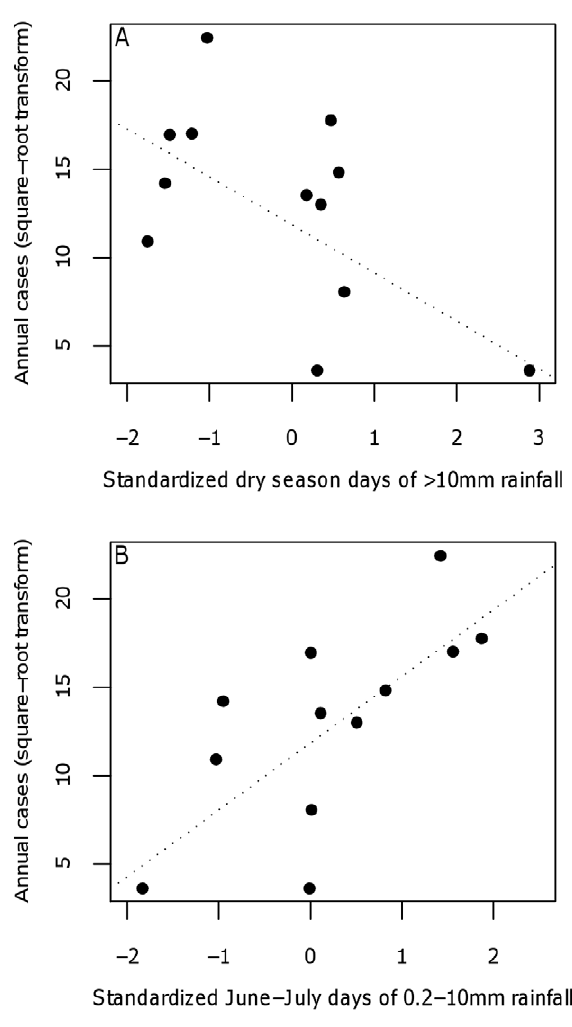
Figure 5. Association between rainfall and plague occurrence. Relationship between square-root transformed number of annual suspect plague cases and (A) the standardized number of days of . 10 mm in the dry season (December-February) prior to the start of the plague year in August (zero-year lag) and (B) the standardized number of days of 0.2–10 mm rainfall in June and July prior to the start of the plague year (zero-year lag). The rainfall data is the weighted ensemble of all seven rainfall datasets included in our analyses (TRMM, CMORPH, FEWS-NET, NCEP/DOE, ERA-Interim, GPCP, and Observation- al). Dotted lines are the regression coefficients estimates from the best two-variable model using the ensemble rainfall dataset. doi:10.1371/journal.pone.0044431.g005 Table 2. Model AICc, D AICc, and adjusted r 2 values for the best fit models (all models with D AICc , 10) using the weighted meteorological dataset ensemble with square-root transformed number of suspect plague cases as the response variable.